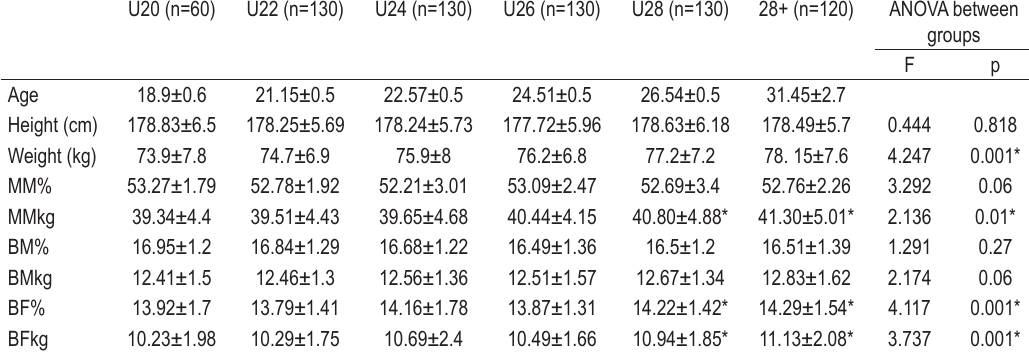
TABLE 2. Descriptive statistics of anthropometric data for age different adult soccer players groups and comparison between the groups